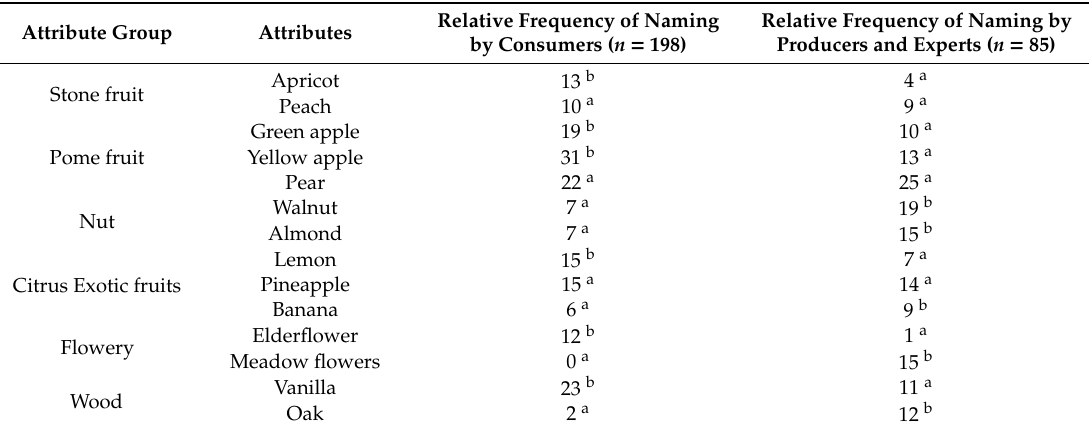
Table 2. Typical attributes for Austrian Pinot blanc: relative frequency of mention by consumers and producers or